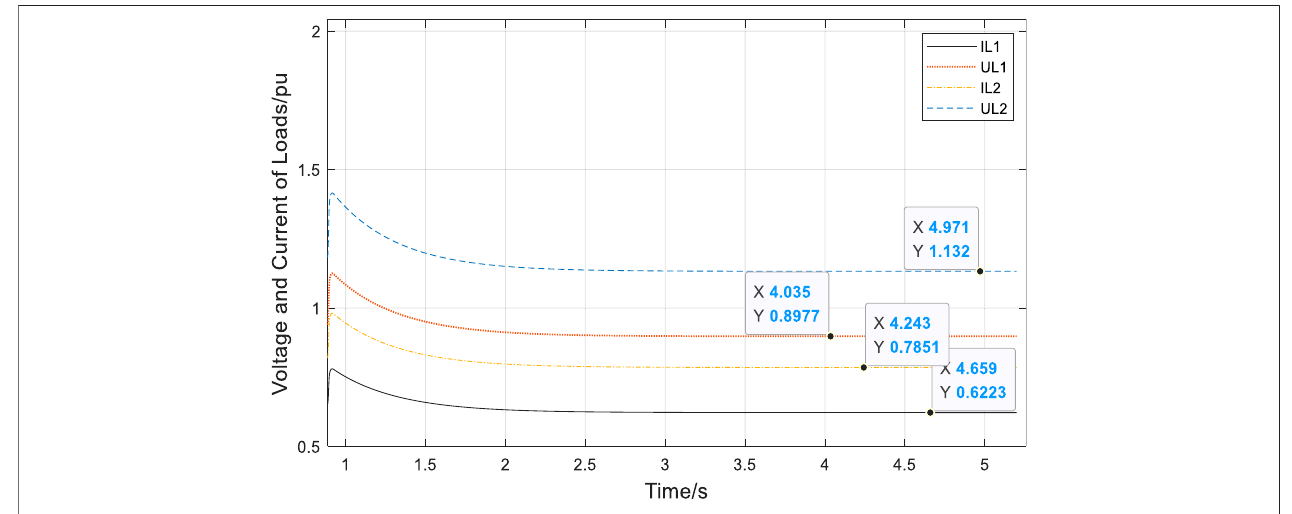
FIGURE 9 | Voltage and current curves on load under operation condition I of the typical APME model.